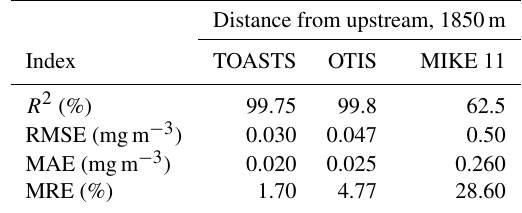
Table 14. Error indices of the Athabasca River experiment (test case 5).